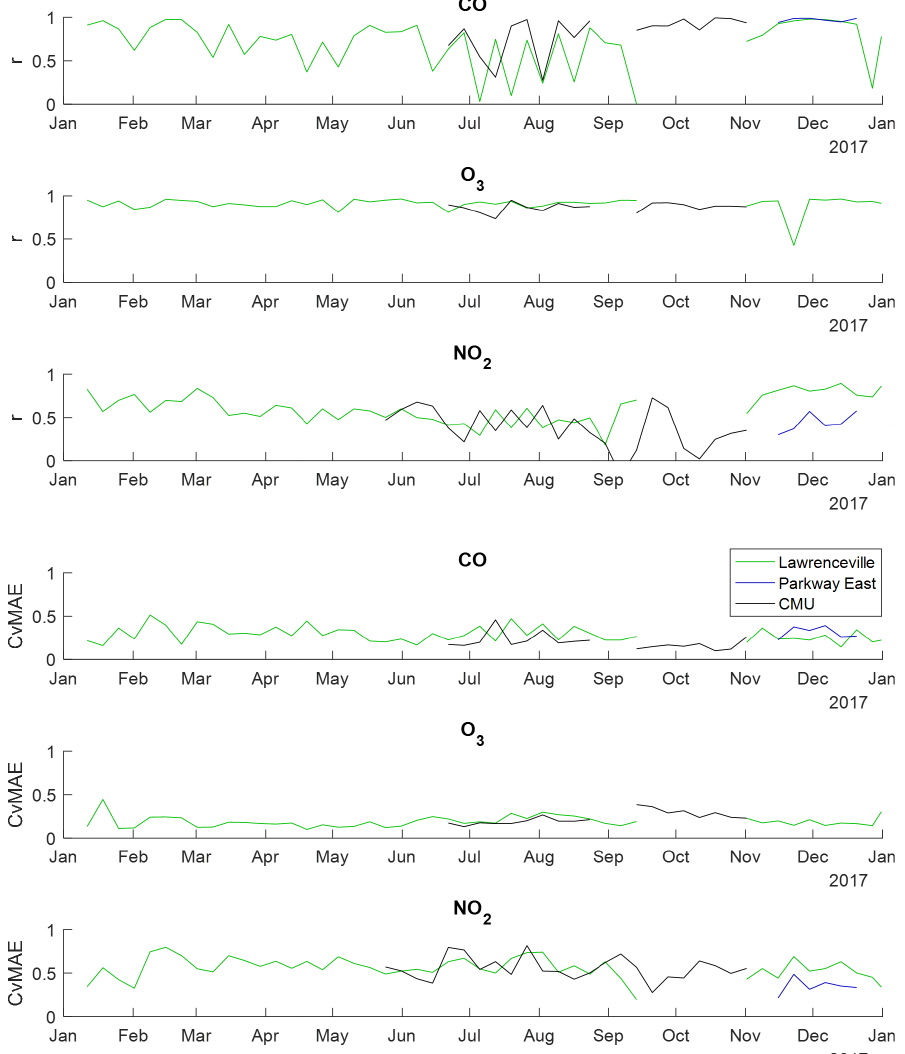
Figure 7. Tracking the performance of RAMP monitors deployed to ACHD Lawrenceville, ACHD Parkway East, and CMU over time. Statistics are computed for each week. Results shown correspond to those of models trained using data collected at the CMU site during 2017. For CO, the generalized limited quadratic regression model is used; for NO 2 and O 3 , generalized hybrid random forest–linear regression models are